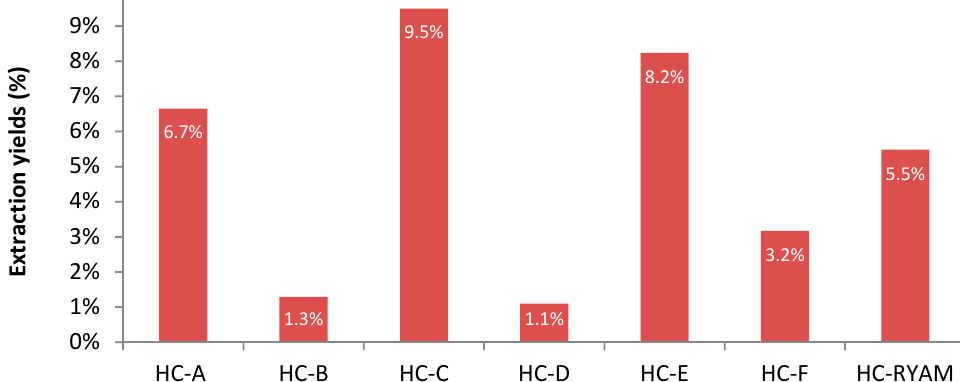
Figure 3. Extraction yields of hemicelluloses from the sulfite pulp as compared to the holocellulose.